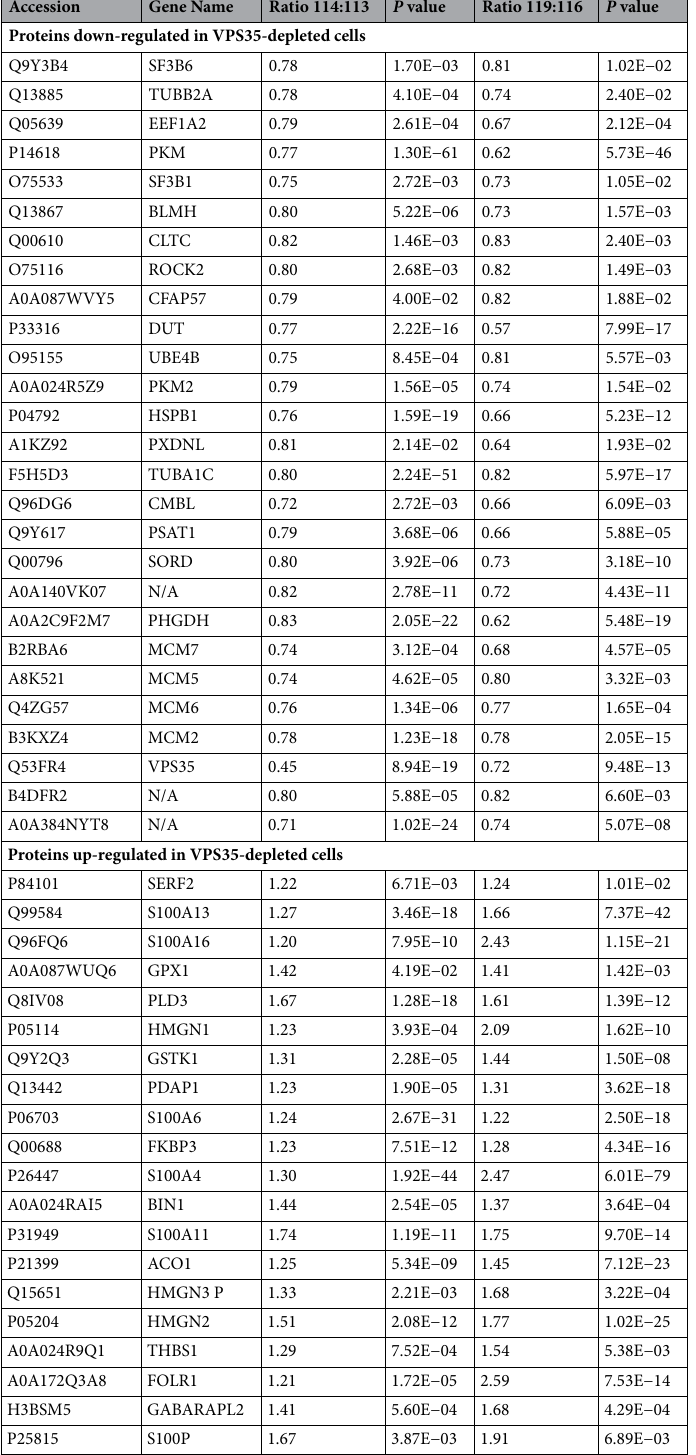
Table 1. Differentially expressed proteins in the nucleus identified by iTRAQ in VPS35-depleted HeLa cells compared to shControl cells. iTRAQ tags Assignment: Replicate 1: shControl-1, 113; shVPS35a-1,